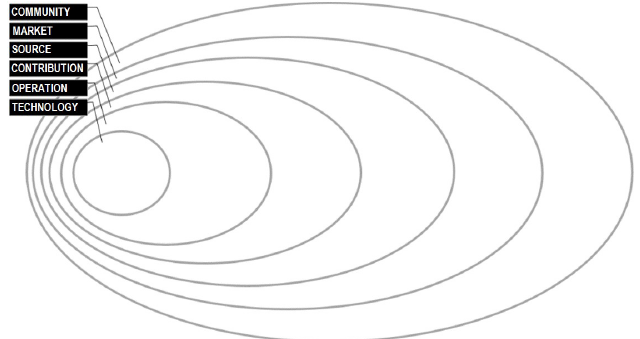
Fig. 17. Actors as mediators in chains of associations, changing the stimulus they receive. Up: human as mediator, translating a certain influence “A” into another “B”; Middle: non-human as mediator, translating a certain influence “A” into another “B”; Bottom: mediators solve conflicts and merge stimuli “A” and “B”, providing a hybrid outcome